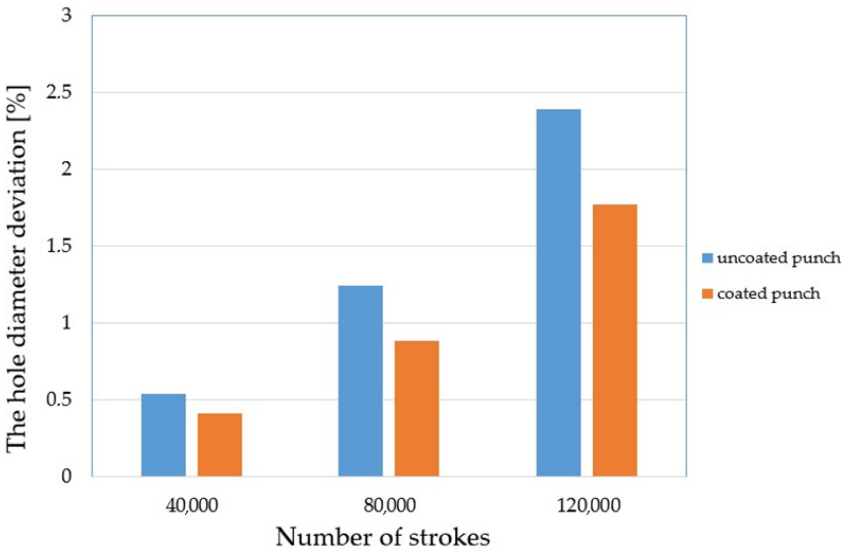
Figure 19. The hole diameter deviation.